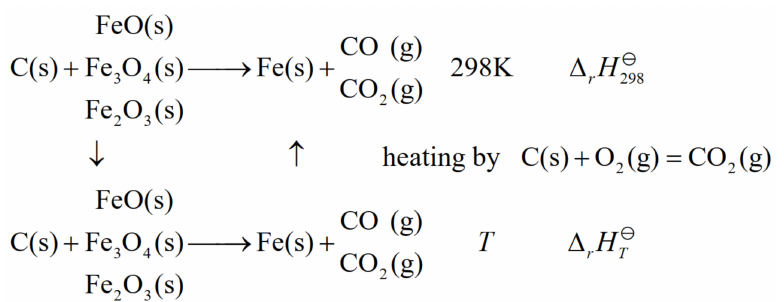
Figure 2. Schematic diagram of energy consumption of the ironmaking by carbon based on Hess’